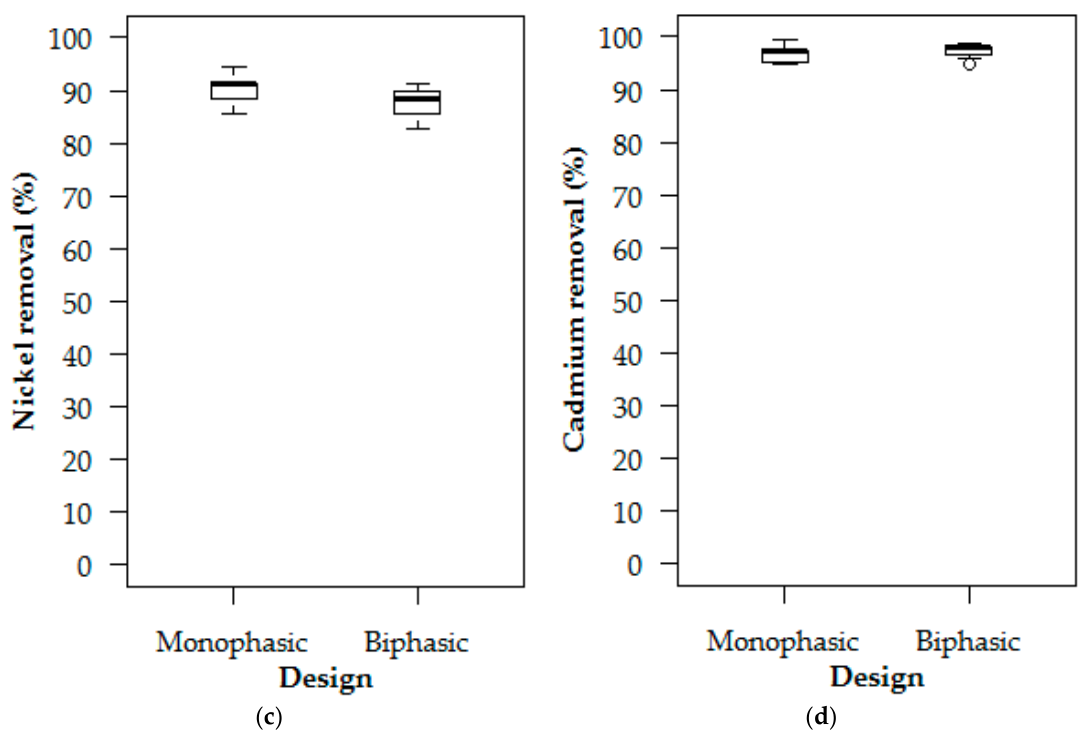
Figure 5. Dissolved-phase heavy metal removal efficiency by design type: ( a ) zinc (Zn); ( b ) copper (Cu); ( c ) nickel (Ni); and, ( d ) cadmium (Cd). “o” indicates outlier.